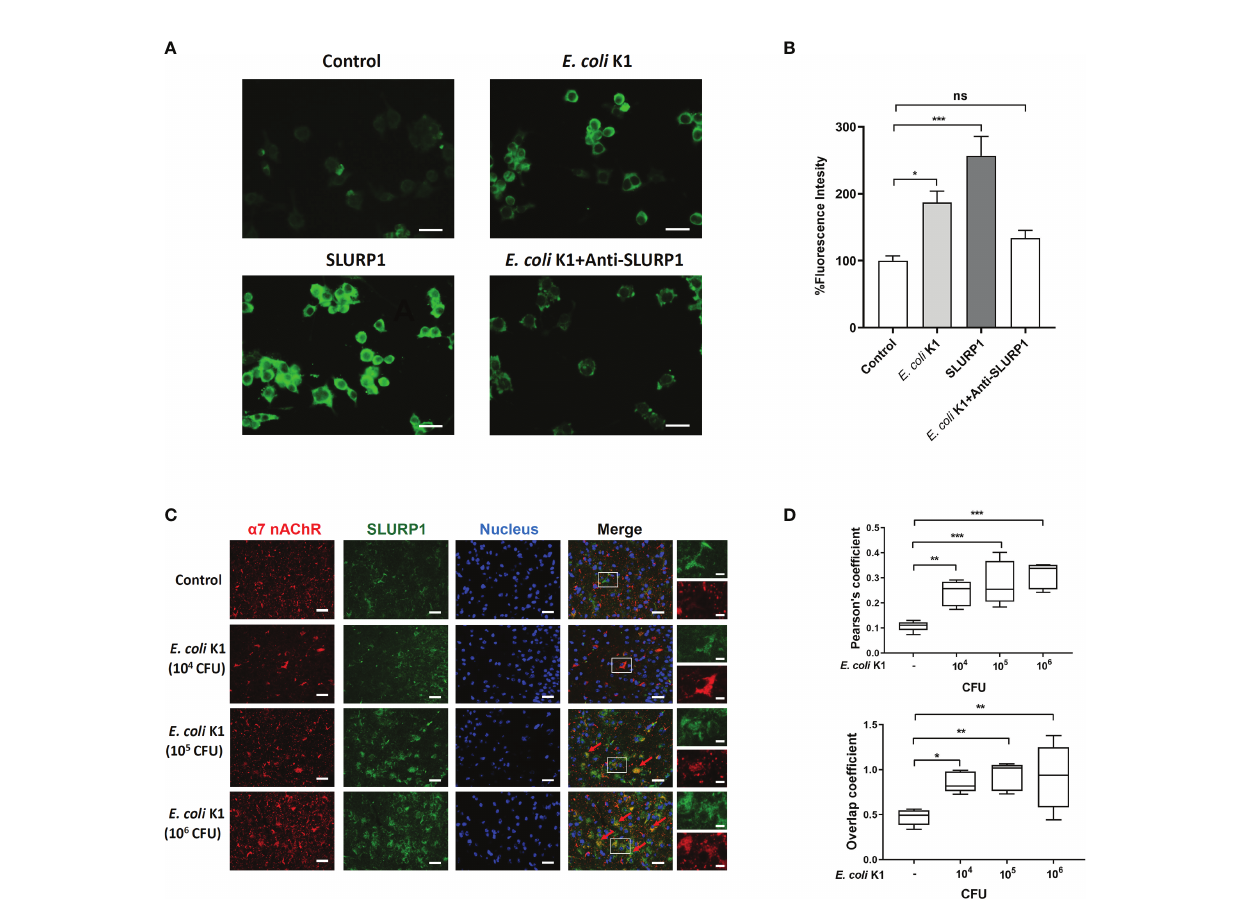
FIGURE 4 | E coli K1-induced SLURP1 activates a 7 nAChR. (A) The Alexa Fluor 488-conjugated a -bungarotoxin binding to HBMEC was detected upon treatment with BSA (control, 2 m g/ml), E coli K1 (1 × 10 5 CFU), SLURP1(2 m g/ml) or E coli K1 (1 × 10 5 CFU) + SLURP1 antibody (1 m g). SLURP1 antibody was added simultaneously with E coli K1. Scale bars = 40 m m. (B) Fluorescence intensity of Alexa Fluor 488-conjugated a -bungarotoxin binding to HBMEC. Data are presented as percent of the control values. (C) The cortex sections of neonatal mice infected with indicated doses of E coli K1 were permeabilized and immuno fl uorescence stained with either a 7 nAChR and SLUPR1 antibodies. Nuclei were stained by DAPI. Arrows show the colonization of a 7 nAChR (red) and SLUPR1 (green). Scale bars = 50 m m (left) or 10 m m (right). (D) Quanti fi cation of the Pearson ’ s correlation coef fi cient (upper panel) and overlap coef fi cient (bottom) for colonization of a 7 nAChR and SLURP1. Data are presented as mean ± SEM from three independent experiments. * p < 0.05; ** p < 0.01; *** p < 0.001 by one-way ANOVA followed by Bonferroni post-hoc test (B, D) . ns, not signi fi